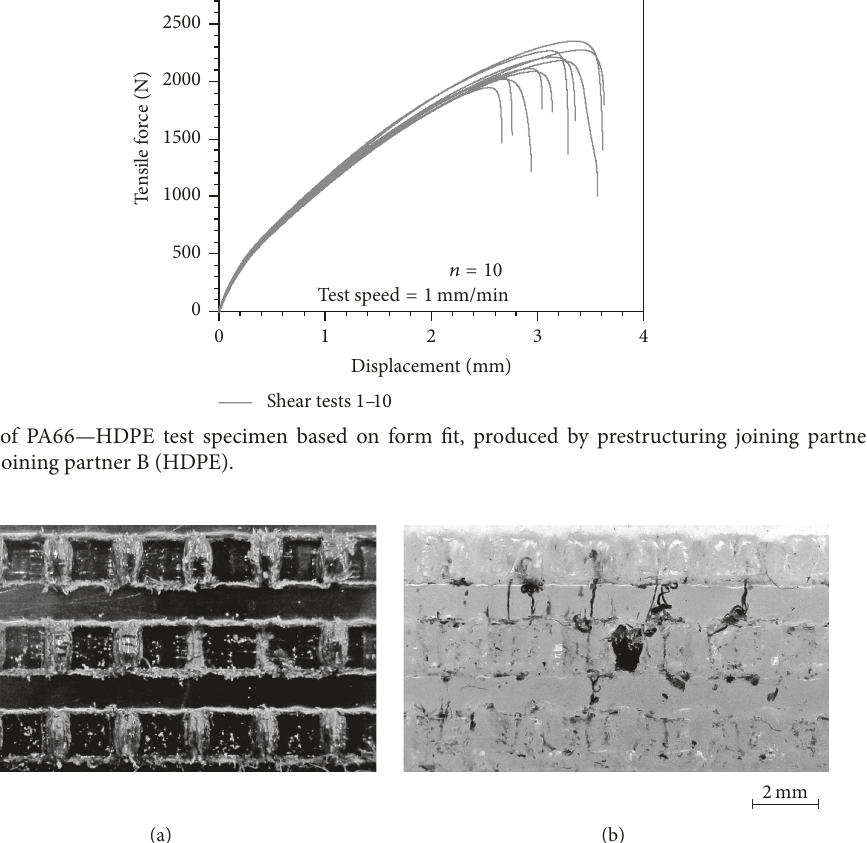
stability of the inserted pin structures, for example, by cross-